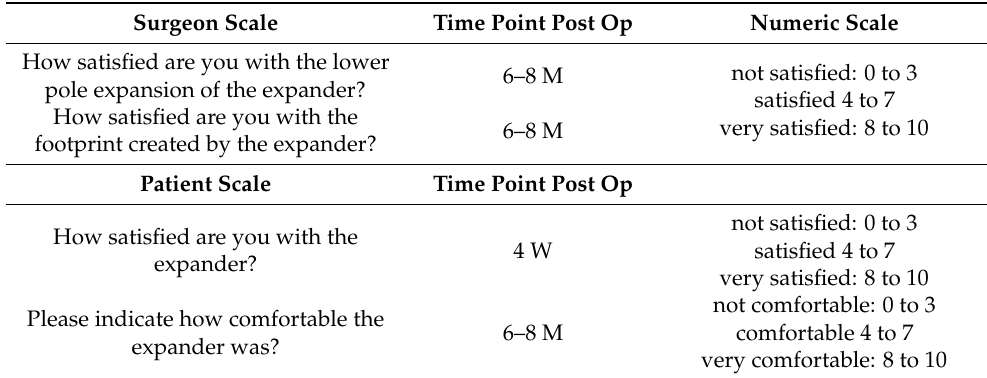
Table 2. Satisfaction questionnaire. Surgeon and patient scale of device aesthetic, practicability, and comfortability outcome, as well as satisfaction after expander-based breast reconstruction with SmoothSilk ® and CPX ®